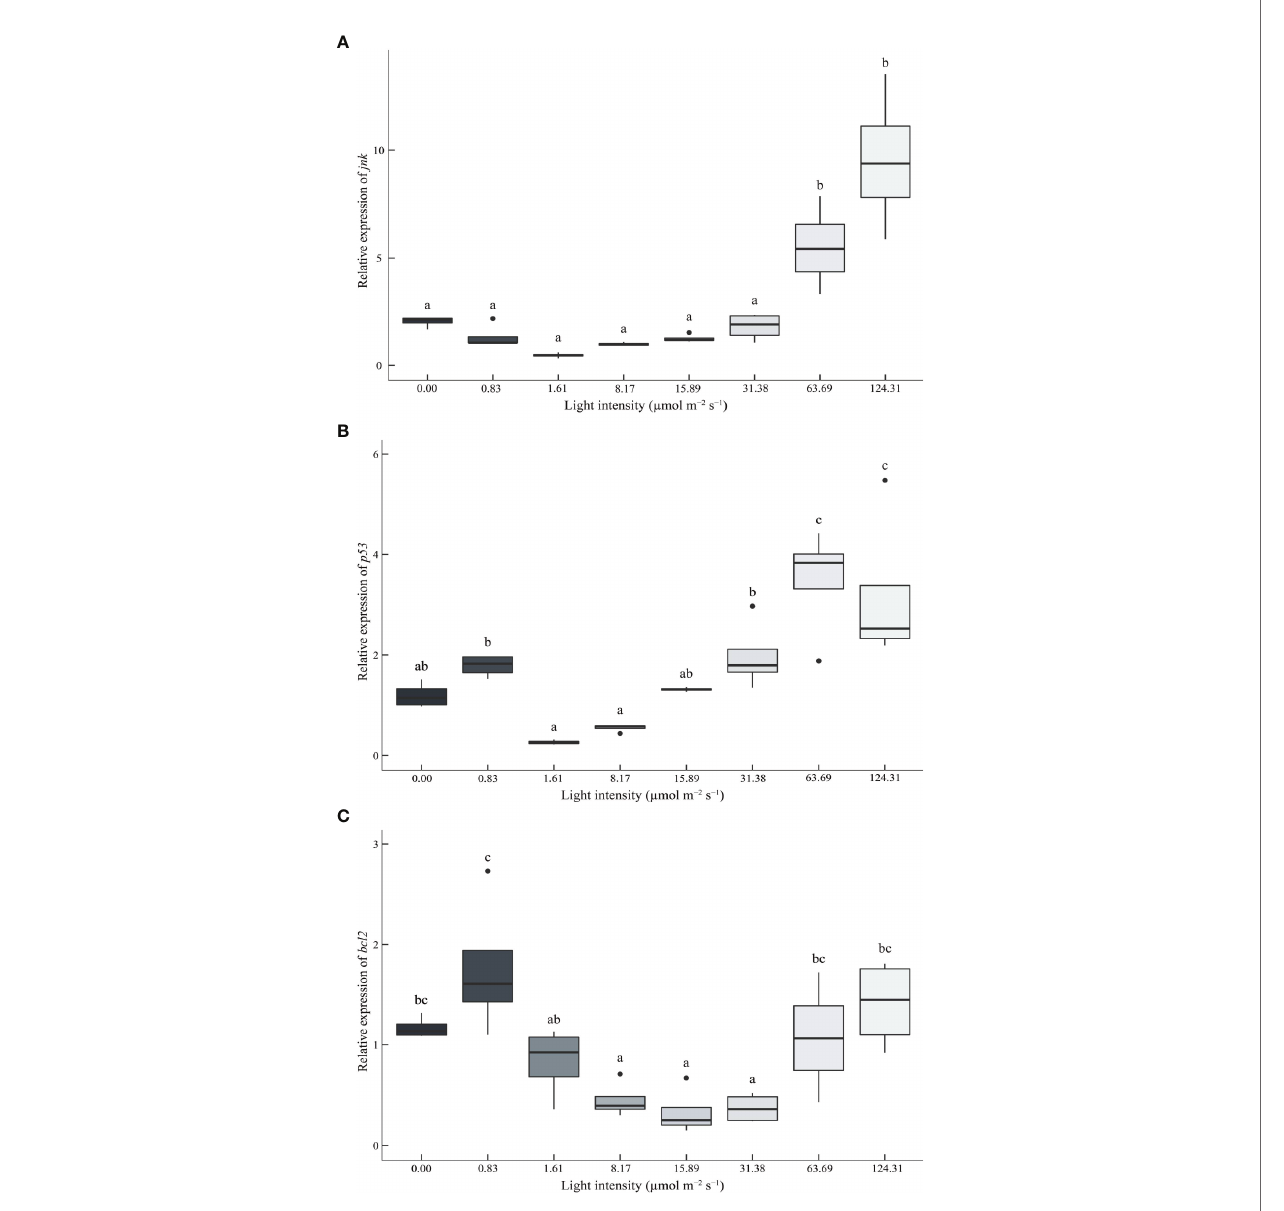
FIGURE 6 | Effect of different light intensities on the c-Jun N-terminal kinase ( jnk ) (A) , tumor suppressor p53 ( p53 ) (B) , and B-cell lymphoma-2 ( bcl-2 ) (C) genes in the hepatopancreas of juvenile Portunus trituberculatus . Data (n = 4) with different letters signi fi cantly differ ( P < 0.05) among